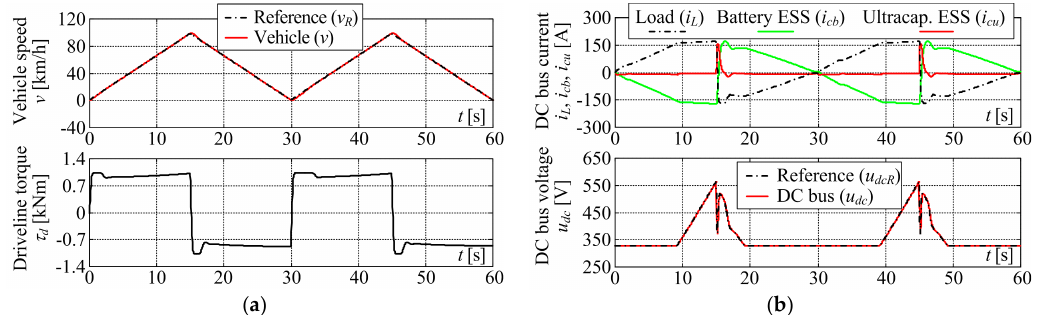
Figure 14. Simulation results for alternating constant acceleration/constant deceleration commands: vehicle speed and driveline torque ( a ) and DC bus load current and voltage profiles ( b ).